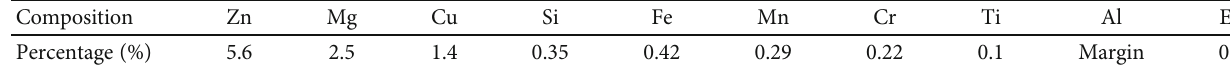
Table 1: 7075-T6 aluminum alloy composition.